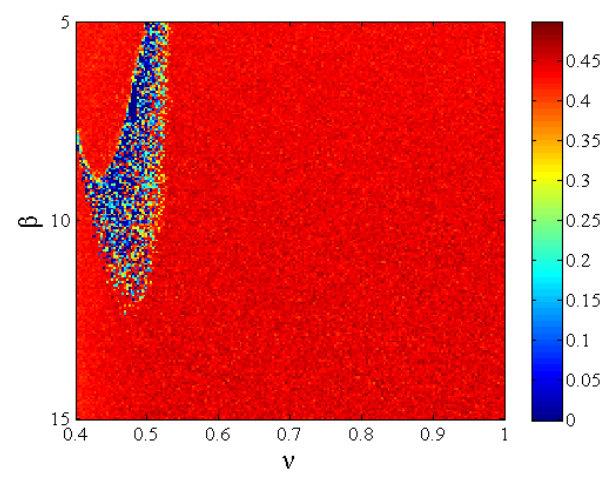
Figure 10. ApEn of the fractional-order map with regard to ν and β .